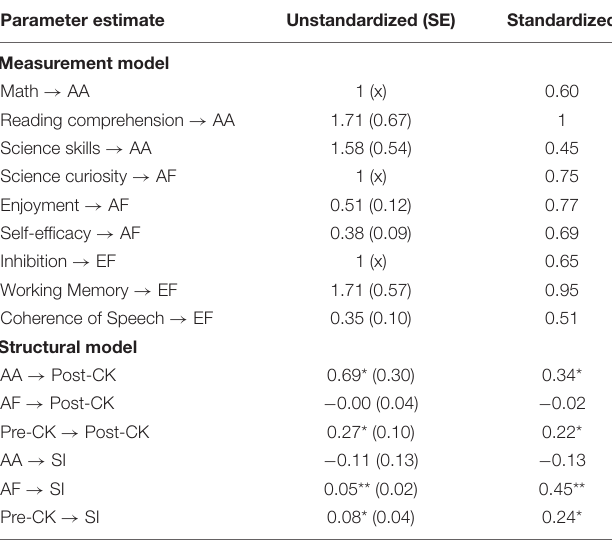
TABLE 6 | Final model parameter estimates, unstandardized and standardized.